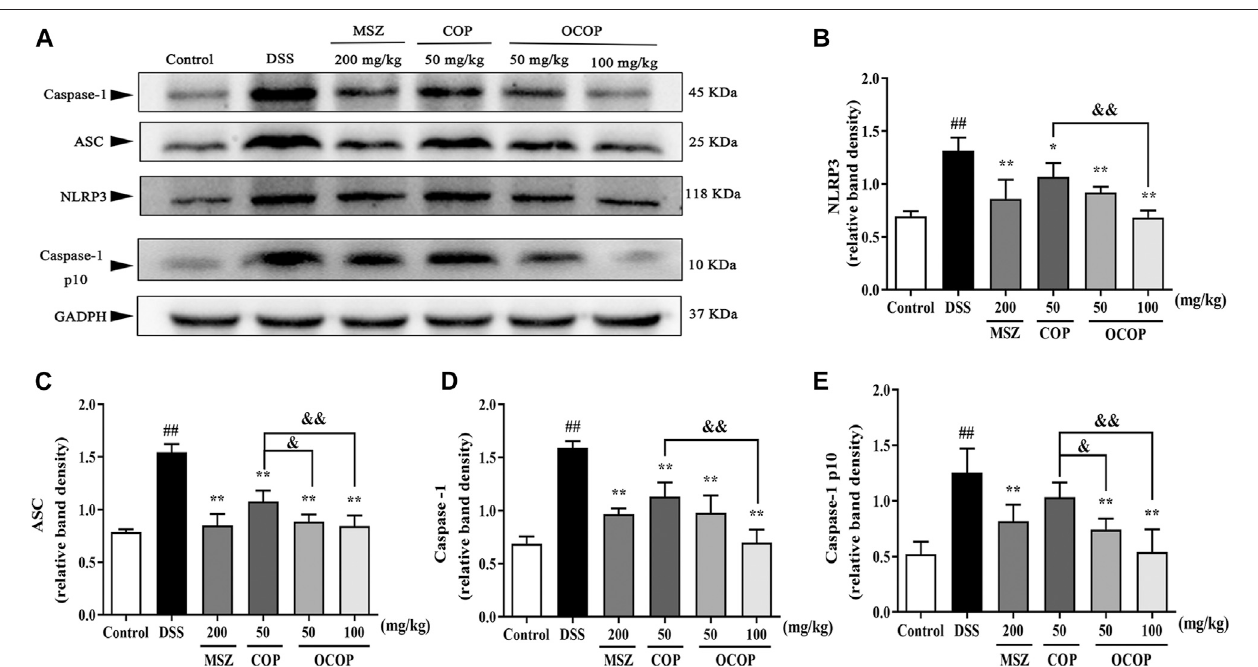
FIGURE9| Effects ofOCOP and COP ontheNLRP3in fl ammasomeinDSS-inducedmice (A) RepresentativeWestern blottingimagesofNLRP3, ASC,Caspase- 1and Caspase-1 p10 (B – E) The protein expression levels of NLRP3, ASC, Caspase-1 and Caspase-1 p10 in the NLRP3 in fl ammasome. Data are expressed as the means ± SD (n (cid:2) 3). # p < 0.05, ## p < 0.01 vs. control group; * p < 0.05, ** p < 0.01 vs. DSS group; & p < 0.05, && p < 0.01 vs. COP group.